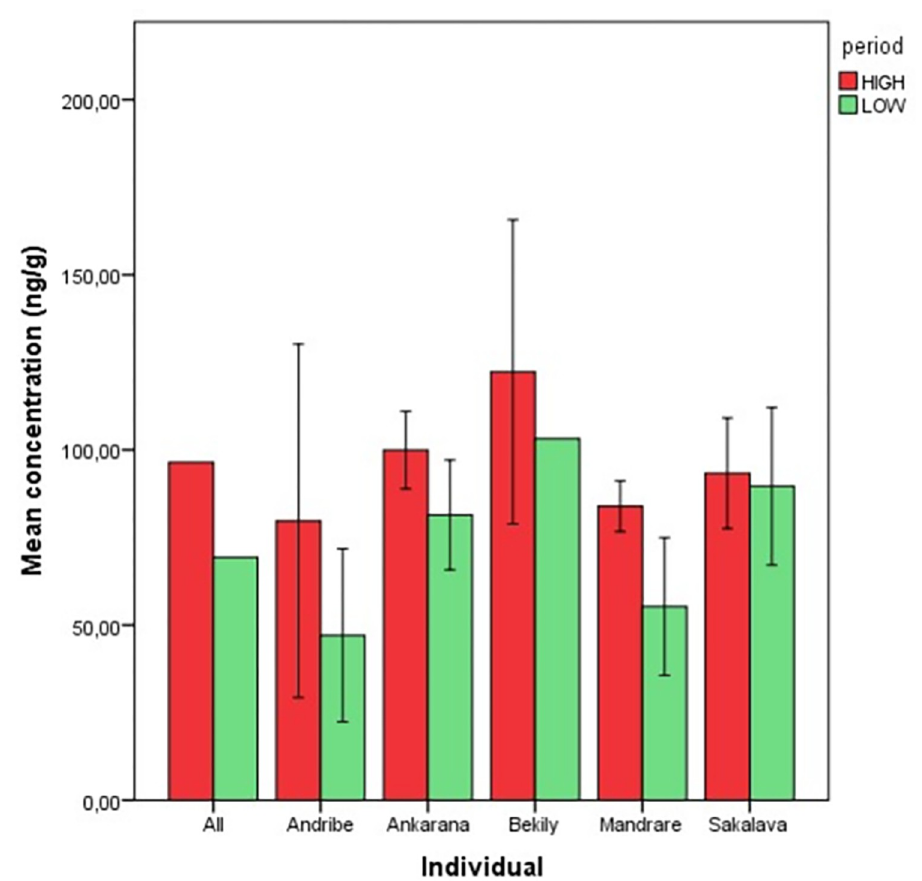
Fig 2. Mean concentrations of faecal cortisol metabolites (FCM) of the five lemurs during the “LOW” and “HIGH” sampling. Mean value ± Standard error are reported.